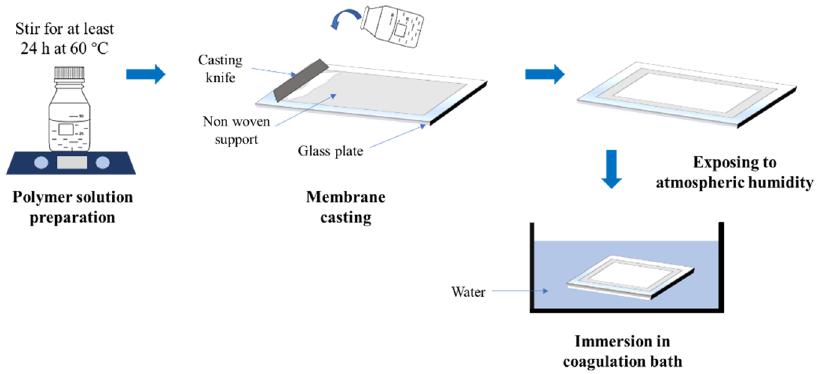
Figure 1 . Simplified process flow of membrane preparation using VIPS method. Figure 1. Simplified process flow of membrane preparation using VIPS